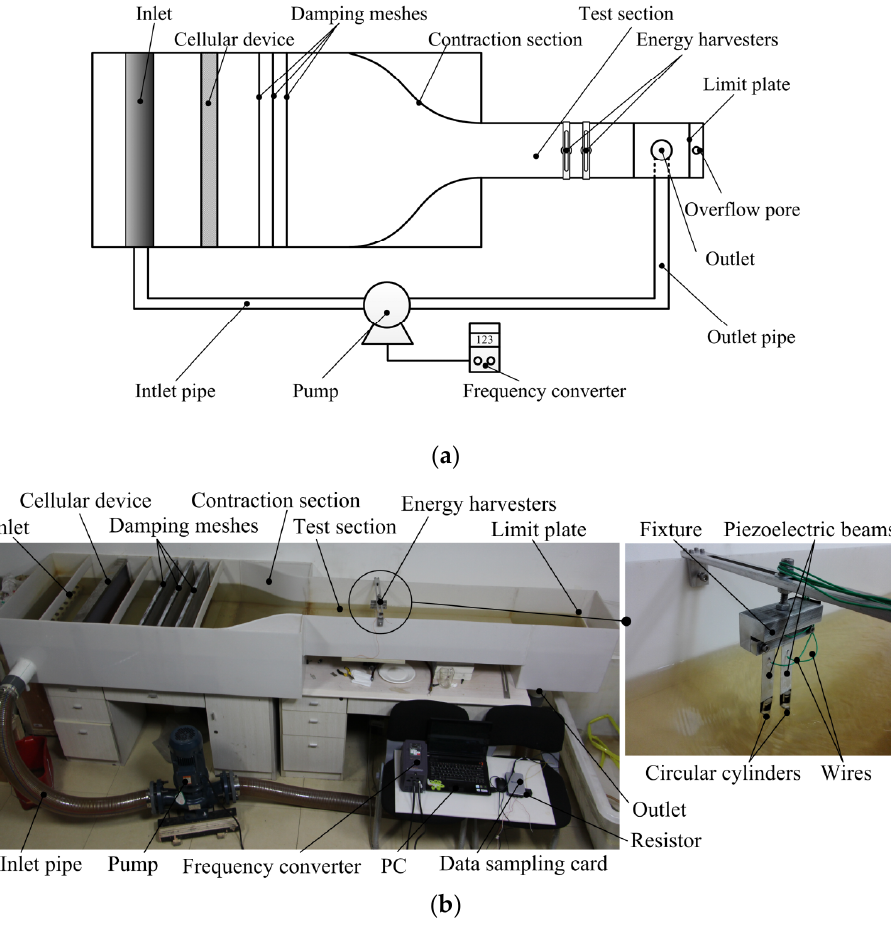
Figure 1. Schematic diagram of the experimental set ‐ up and a picture of the experimental platform: ( a ) Schematic diagram of the experimental set ‐ up; ( b ) Experimental platform.